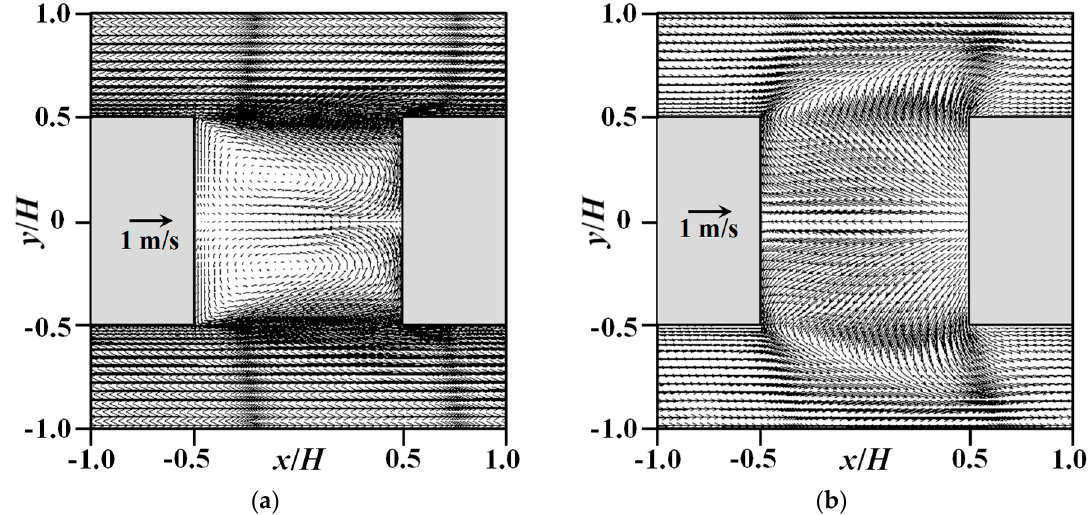
Figure 7. Mean velocity vectors in horizontal planes of the TSC (GH-30): ( a ) z / H = 0.5; ( b ) z / H = 0.1.